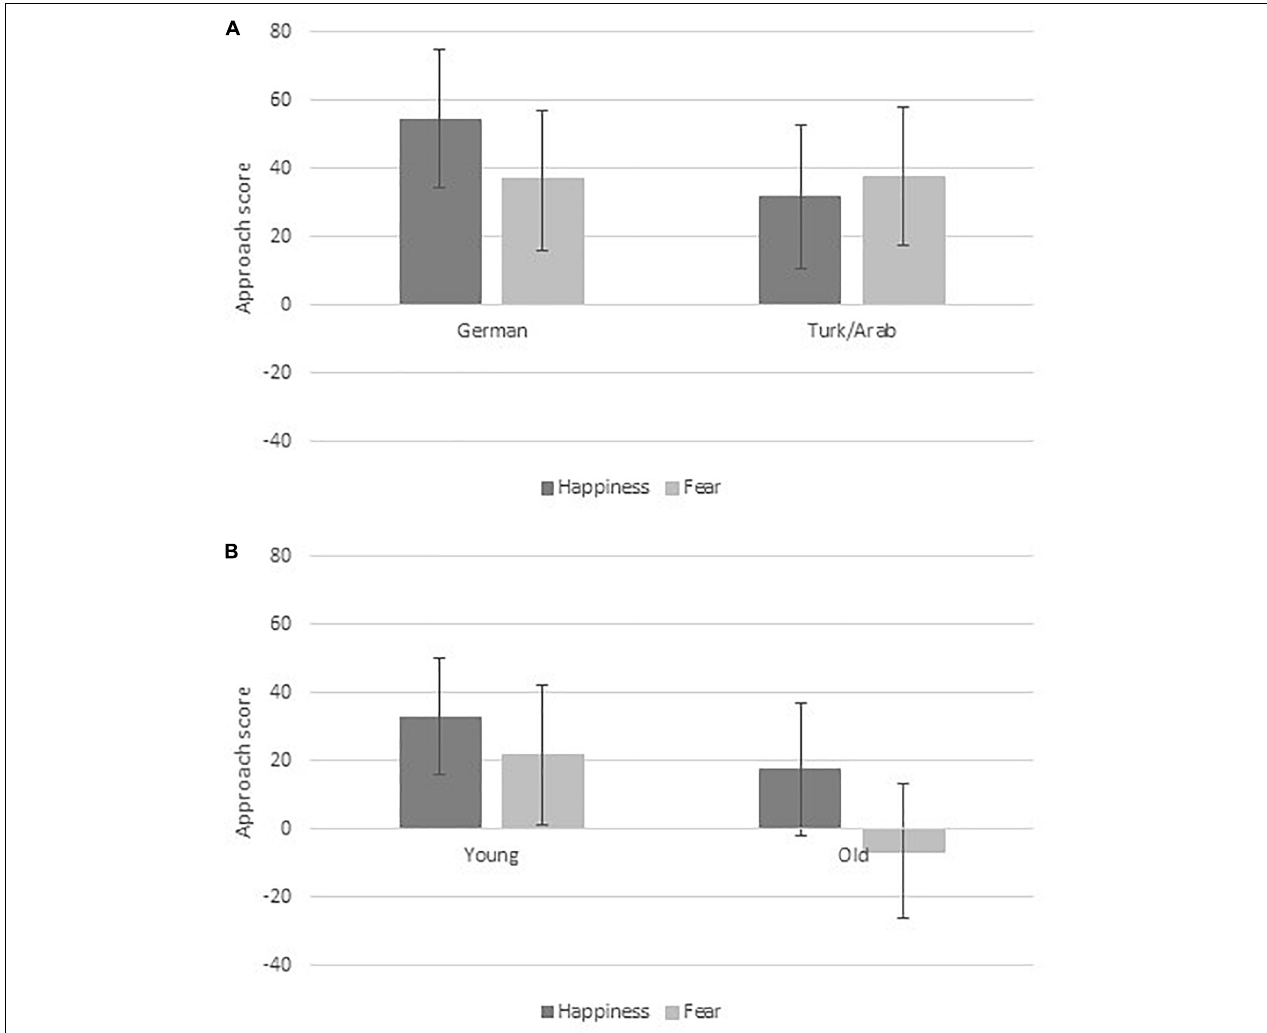
FIGURE 2 | The approach scores (i.e., the difference in mean RT between approach and avoidance responses; whiskers are standard errors) for (A) the 2 (ethnicity: German vs. Turk/Midle-Eastern) × 2 (emotion) design and (B) the 2 (age: young vs. old) × 2 (emotion) design.